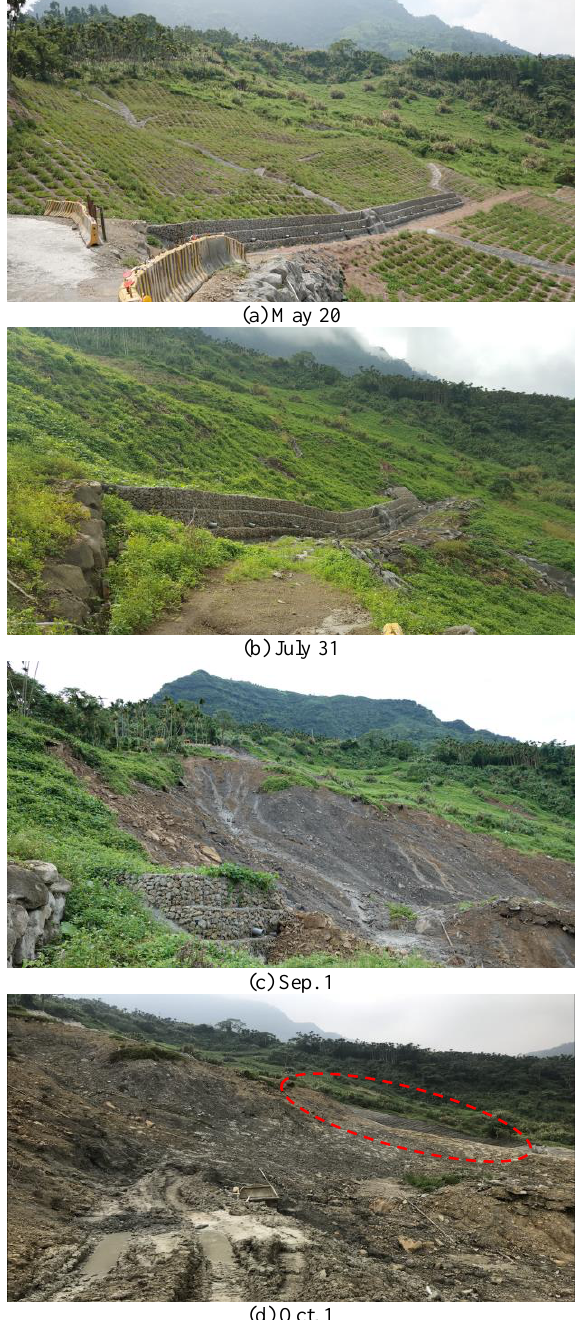
Figure 13. In-situ photos for different